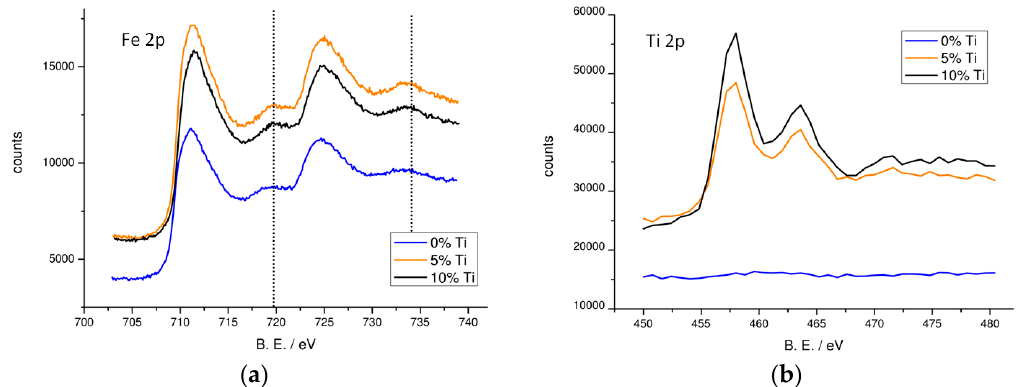
Figure 2. XPS spectra in the Fe and Ti energy region. ( a ) Fe 2p and ( b ) Ti 2p core level XPS spectra for un-modified (blue line), 5% (orange line) and 10% Ti-modified (black line) hematite samples. Dotted bars in ( a ) indicate Fe 3+ shake-up peaks. Measurements have been performed with a 45° take off angle.